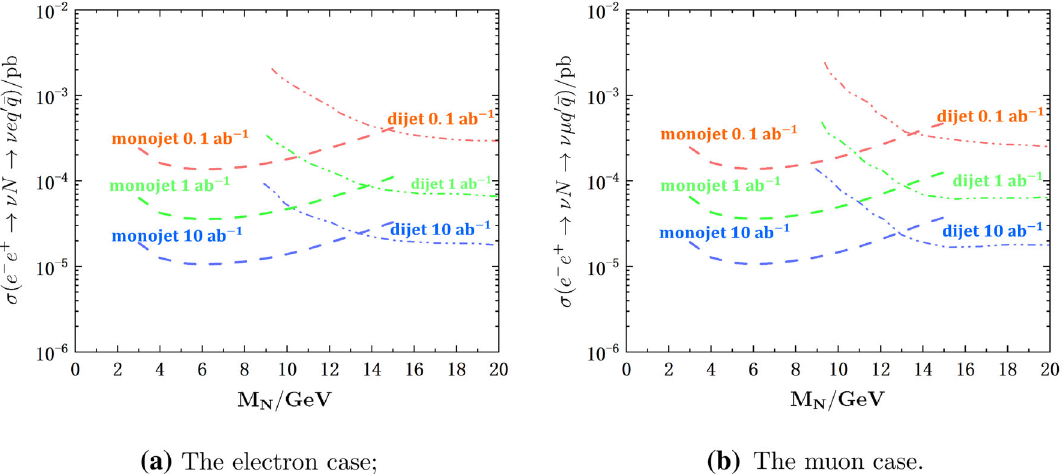
GeV. In the right panel, the red cone includes the particles with angular separations smaller than 0.11 from the jet direction, and they in total are required to account for less than 90% of the transverse jet momentum > 5 T